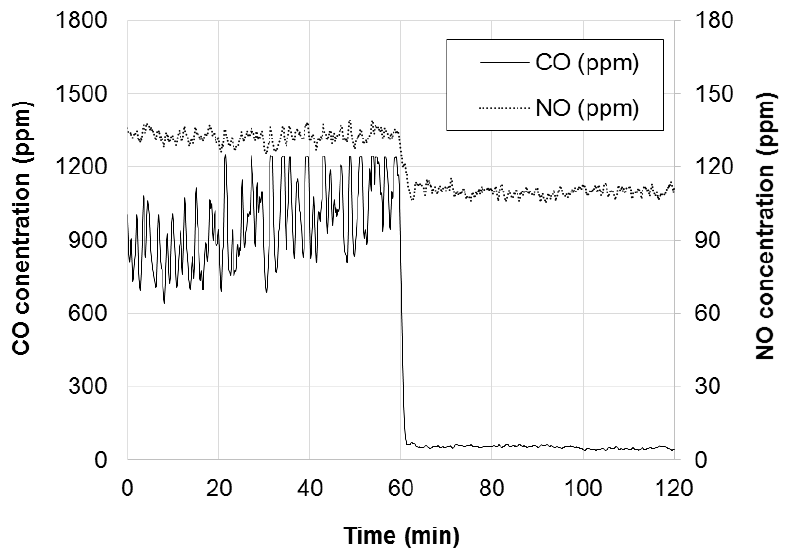
Figure 3. Effect on CO and NO emissions of injecting 4.0 L/h solution of 20 wt% of (NH 4 ) 2 SO 4 in